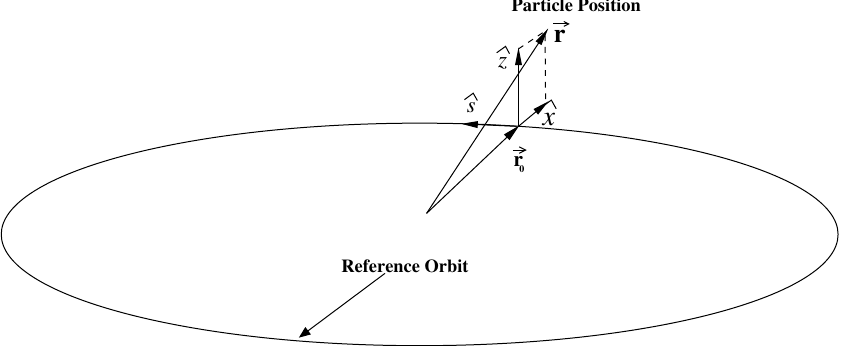
is the reference 0